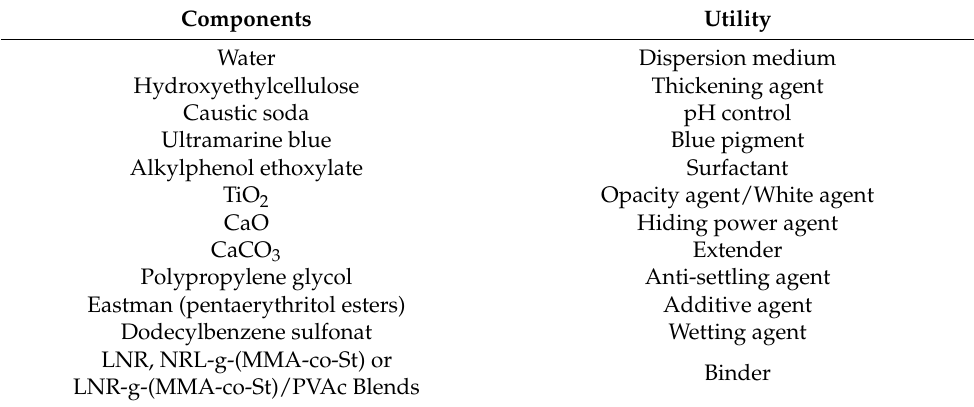
Table 1. Paint components, function, and grade.